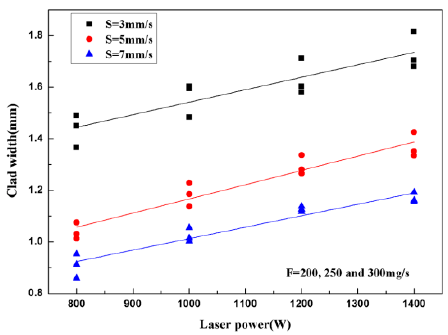
Figure 4. The e ff ect of the main processing parameter on the clad width ( w Figure 4. The effect of the main processing parameter on the clad width ( w ). Figure 4. The effect of the main processing parameter on the clad width ( w ).